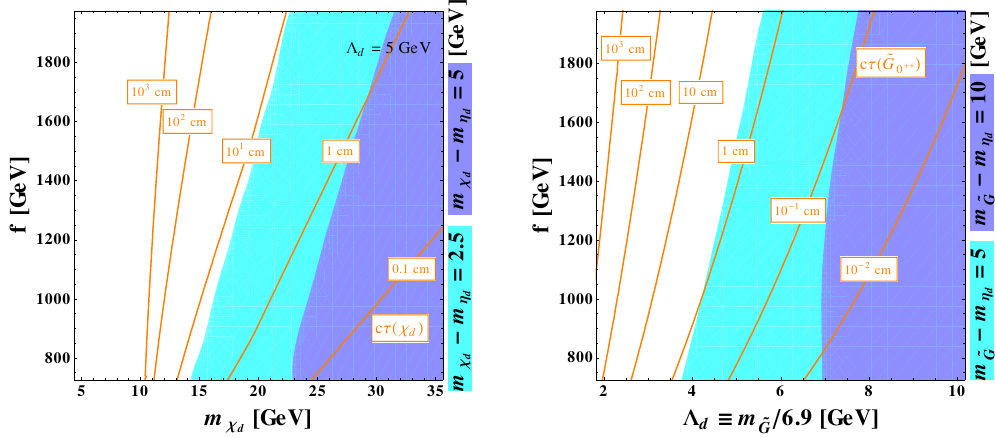
Figure 5 . Left : constraints on the scalar meson lifetime in the Higgs portal scenario derived by requiring (cid:10) (cid:17) < (cid:10) DM . The light and dark blue regions both extend to m (cid:31) d (cid:31) d becomes heavier than the scalar glueball. Right : constraints on the glueball lifetime assuming m < m (cid:31) . The dark blue region is laid on top of the light blue region. The mass relation d e G 0++ eq. (3.7) is assumed in these